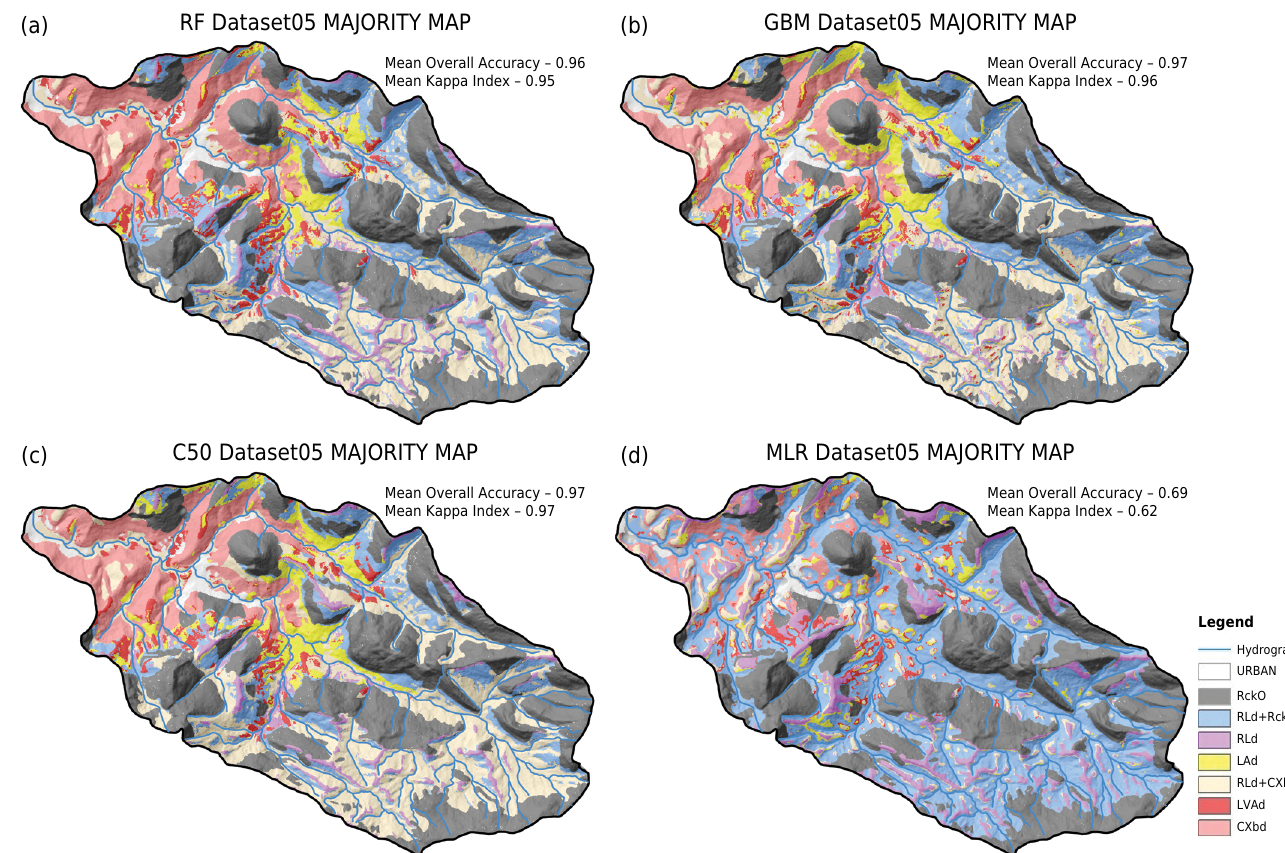
Figure 9. Output maps produced by Dataset05, with mean overall accuracy and kappa index.